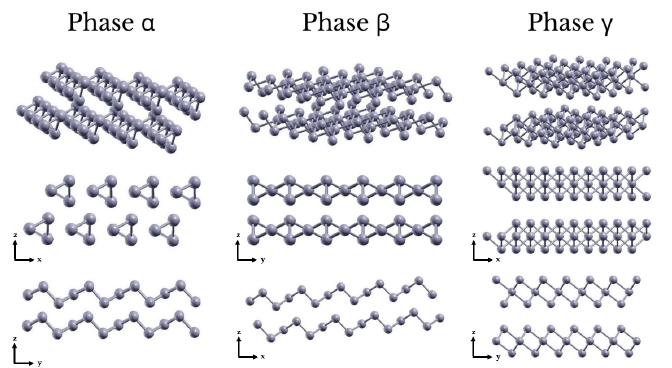
Figure 1. Perspective and side views of the crystal structures of bilayer (2L) α -, β - and γ -phase of